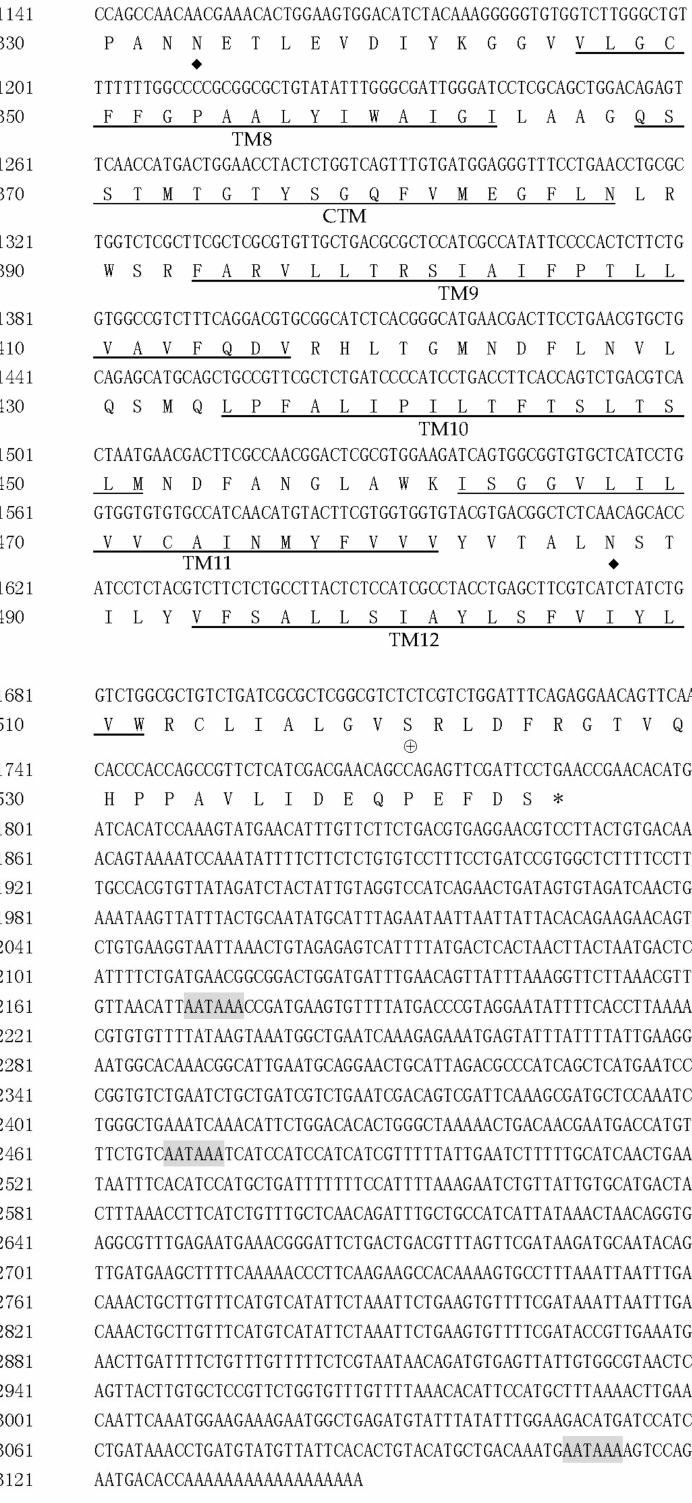
Figure 1. The nucleotide and deduced amino acid sequence of maNramp . Twelve transmembrane regions (TMs) and a consensus transport motif (CTM) were underlined. (cid:7) , N-glycosylation sites; (cid:78) , predicted protein kinase C phosphorylation sites; (cid:70) , a tyrosine kinase phosphorylation site; ⊕ , casein kinase II phosphorylation sites. The CAGTG regions make the text bold. The poly(A) signal (AATAAA) were